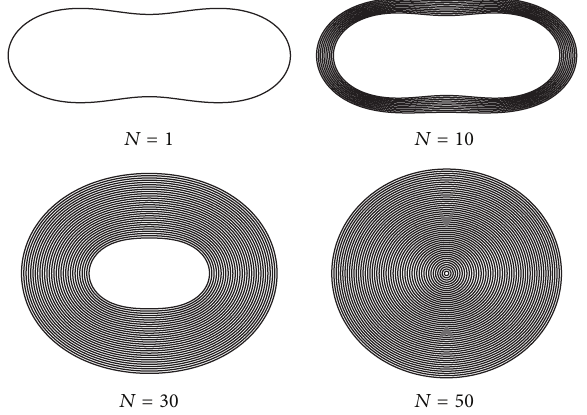
Figure 8: 𝑁 -dependence of the cross-section. Γ𝑟 𝑁 = 0.02 and /𝐸 = 0.1 are fixed for all 𝑘𝑟 𝑁